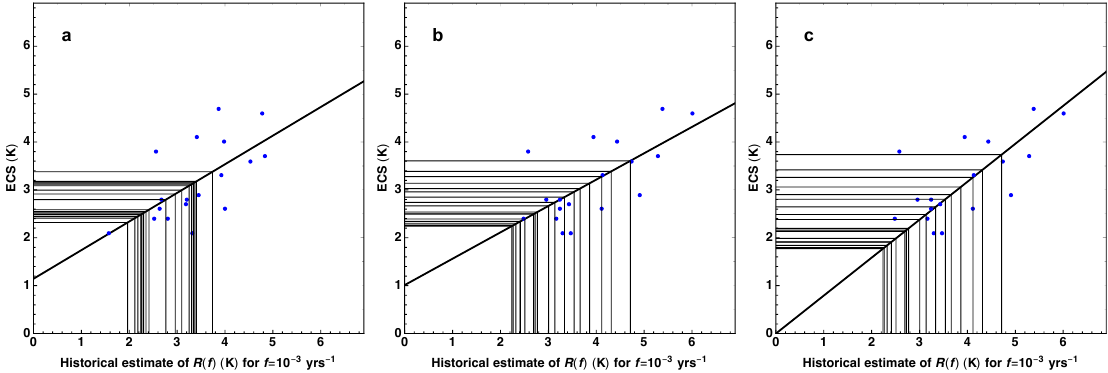
Figure 4. ( a ) The points in the scatter plot are the same as (the letters) in Figure 3a. The line is the least-square fit of the model ECS = aR + b . The vertical lines correspond to the R -values estimated from the instrumental temperature record for the different modified Hansen forcing time series. The horizontal lines show how these R -values are mapped to ECS-values by the linear model. ( b ) As in ( a ), but prior to the analysis the volcanic forcing is reduced to half of its original values. ( c ) As in ( b ), but using a linear model ECS = aR with zero intercept to map R -values to